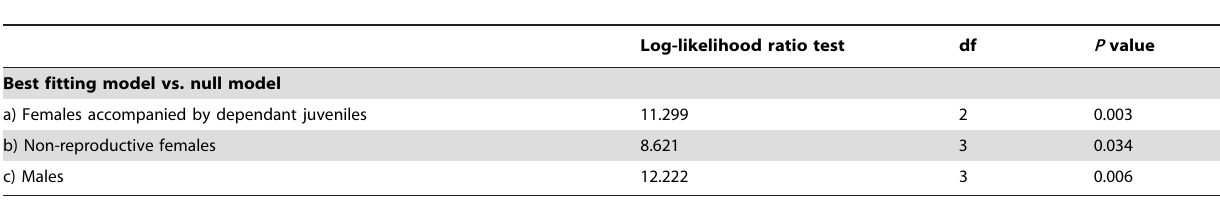
Table 4. Comparison between the best-fitting candidate models and a null model.